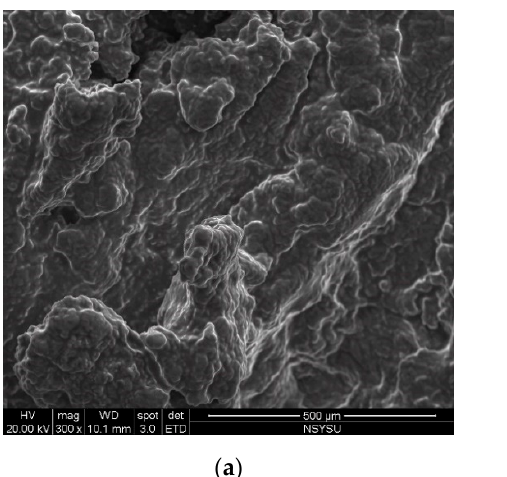
Table 1. Fatty acid composition of cobia liver oils obtained from EAAE and AE.